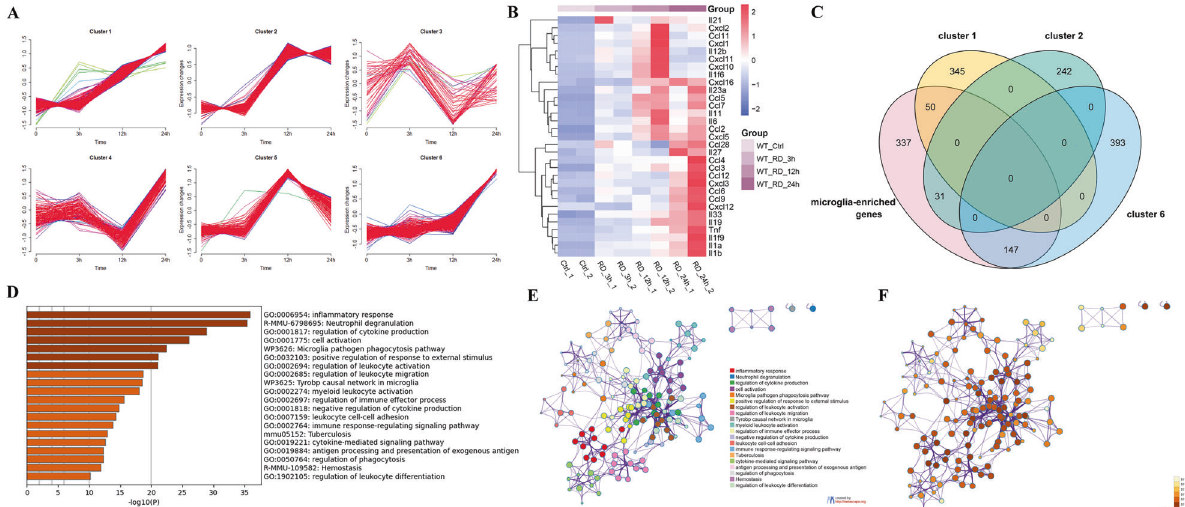
Fig. 1 Early in fl ammatory responses with increased cytokine and chemokine gene expression following RD. A Time-course transcriptional pro fi les of up-regulated DEGs in WT mouse retina within 24 h after RD. B Heatmap of in fl ammatory cytokine and chemokine expression in the up-regulated DEGs. C Venn diagram showing the overlapped genes among Cluster 1, Cluster 2, Cluster 6, and microglia-enriched genes. D The top 20 GO terms and pathways over-represented by genes of Cluster 6. E Network of enriched terms colored by cluster ID, where nodes that share the same cluster ID are typically close to each other. F Network of enriched terms colored by p value, where terms containing more genes tend to have a more signi fi cant p